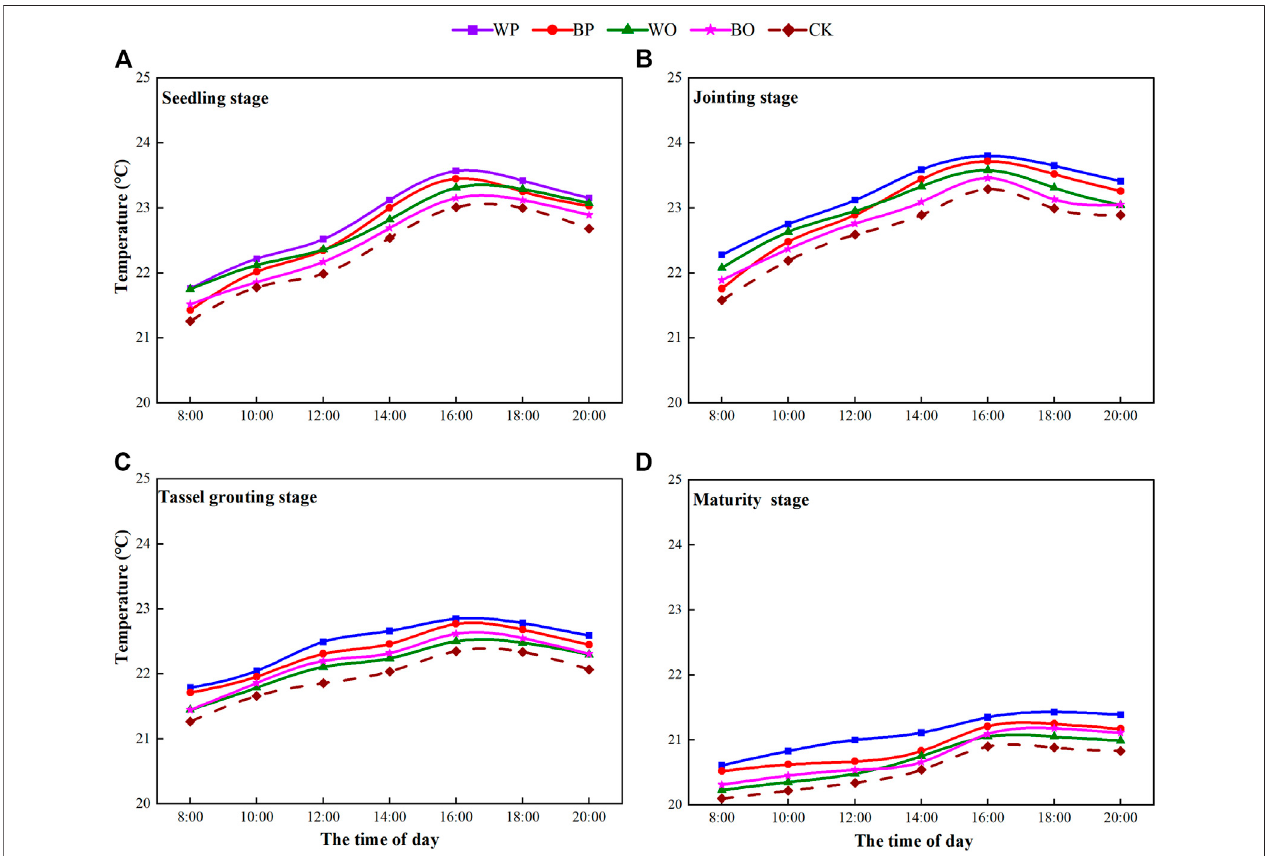
FIGURE3| Diurnalvariationsofsoiltemperaturein15 – 25cmsoillayerunderdifferentmulching fi lmsofSeedlingstage (A) ,Jointingstage (B) ,Tasselgroutingstage (C) and Maturity stage (D) .